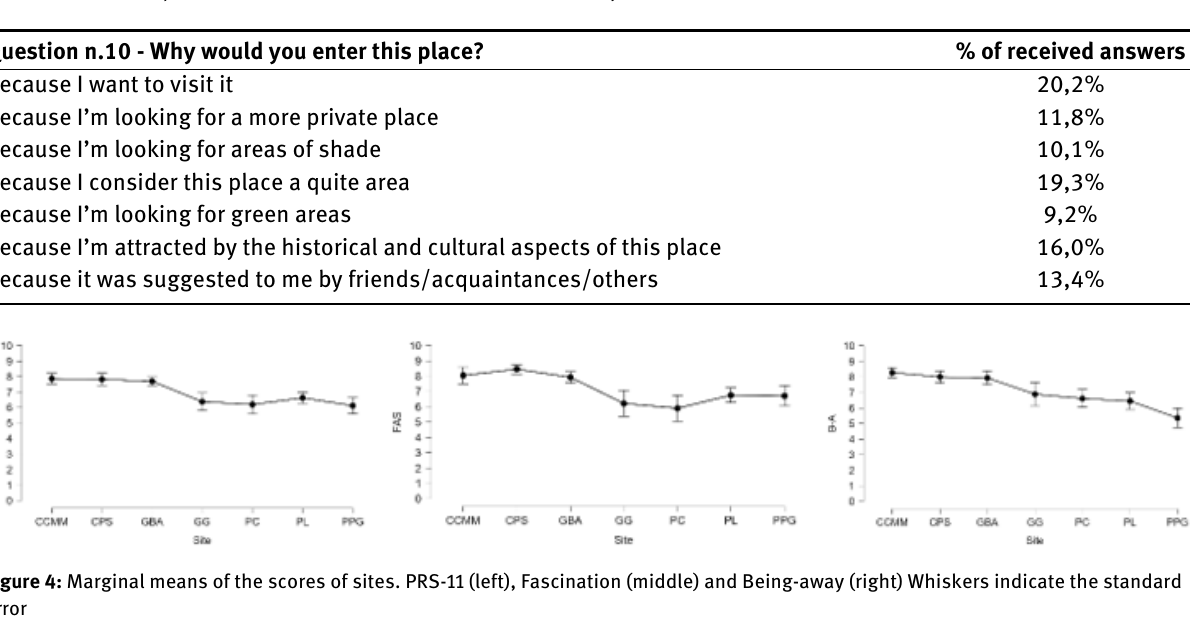
years), 21% (25-39 years), 32% (40-60 years), 29% (> 60 years). Regarding gender, 41 males and 76 females partici- pated to the survey, while 1 participant didn’t answer and